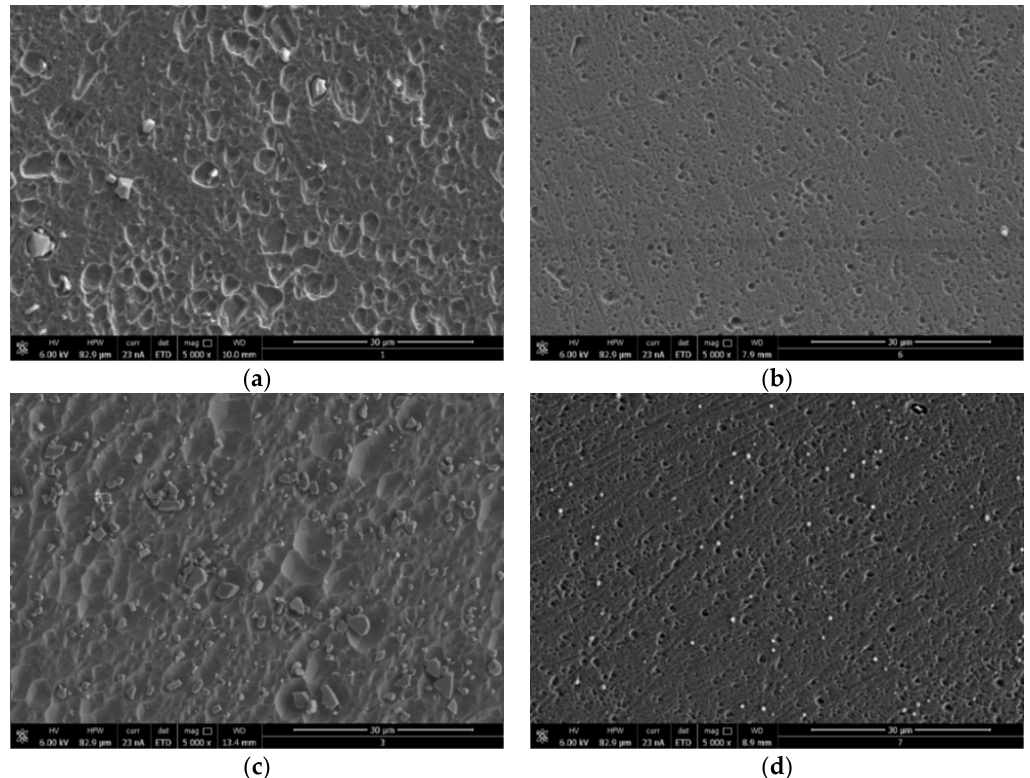
Figure 7. SEM images of the aluminium surface after 24 h of immersion in 1-M HCl without and with the presence of the optimum concentration of GG (i.e., 0.4 g / L) ( a ) in the blank solution and ( b ) in the presence of GG at 25 ◦ C, respectively, and ( c ) in the blank solution and ( d ) in the presence of GG at 45 ◦ C, respectively. Table 6. EDS analysis result of the aluminium surface after 24 h of immersion in 1-M HCl without and with the presence of the optimal concentration of GG (i.e., 0.4 g / L). Element Weight % - 25 ◦ C Blank GG Blank